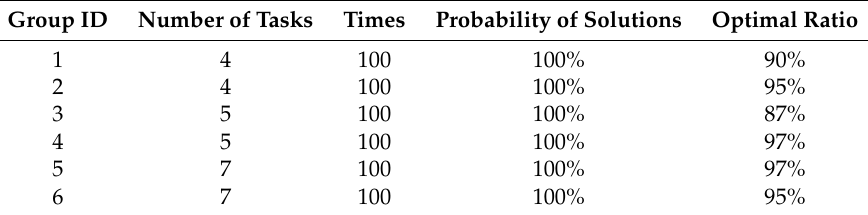
Figure 14. Solving Costs with Increasing Number of Related Tasks. Table 5. Results of